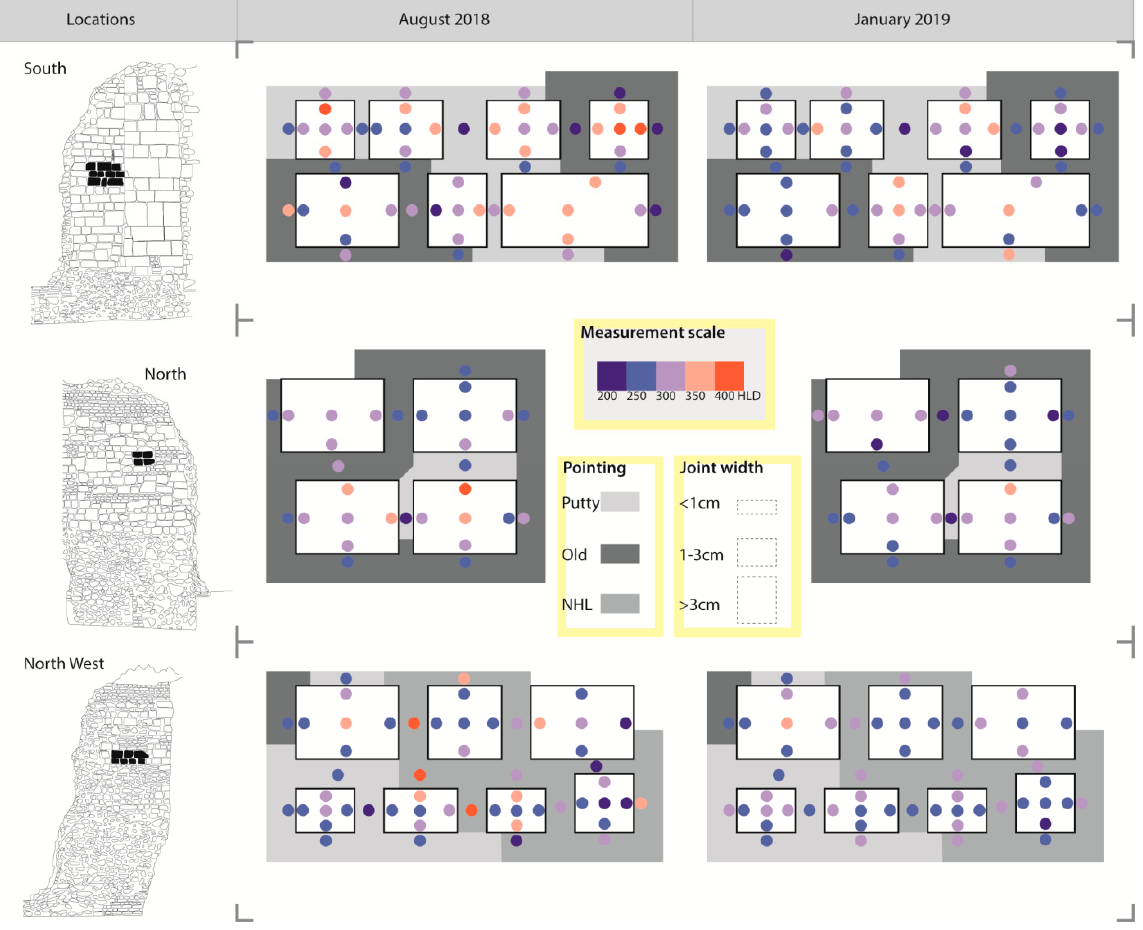
Figure 8. Distribution of surface hardness measurements at individual stone scale across two separate surveys, showing HLD for individual Reigate block edges and centres (5–8 measurements per point). Local variation across individual blocks irrespective of adjacent mortar type, and lack of clear patterns according to mortar type, demonstrate the caution is necessary when interpreting the generalised findings made in the ANOVA test. Local factors, such as micro-contextual shelter and joint width may override any controlling effect of the mortar type. Table 5. Total number of surface hardness measurements on different materials, average measure- ment value, and standard deviation in HLD across survey dates and locations depicted in Figure